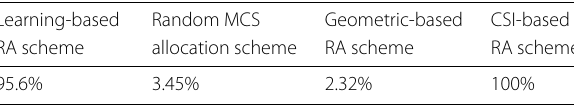
Table 5 Comparison of system goodput (in % age) for different schemes w.r.t. CSI-based RA